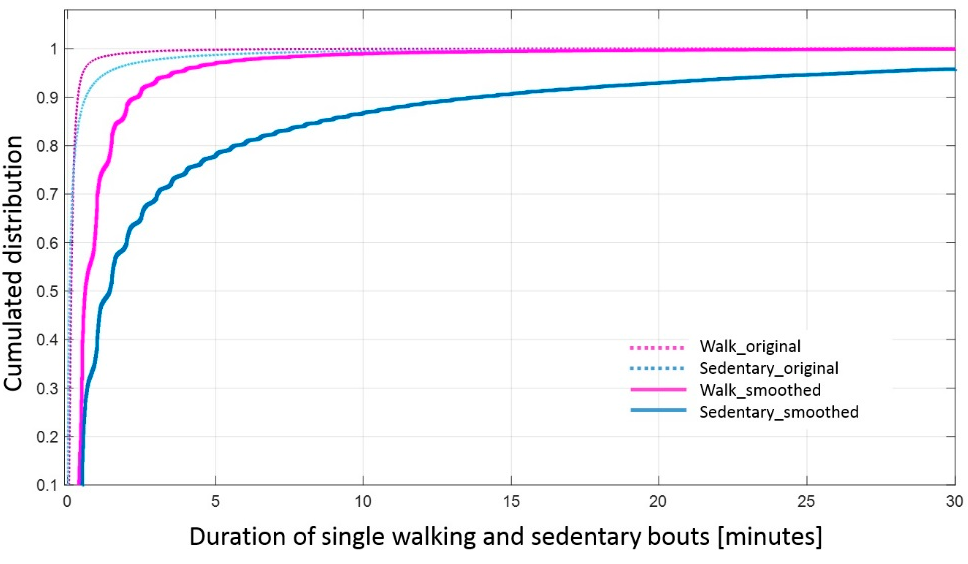
Figure A1. Comparison of cumulated distribution of walking and sedentary bouts before and after smoothing of activity classification output.